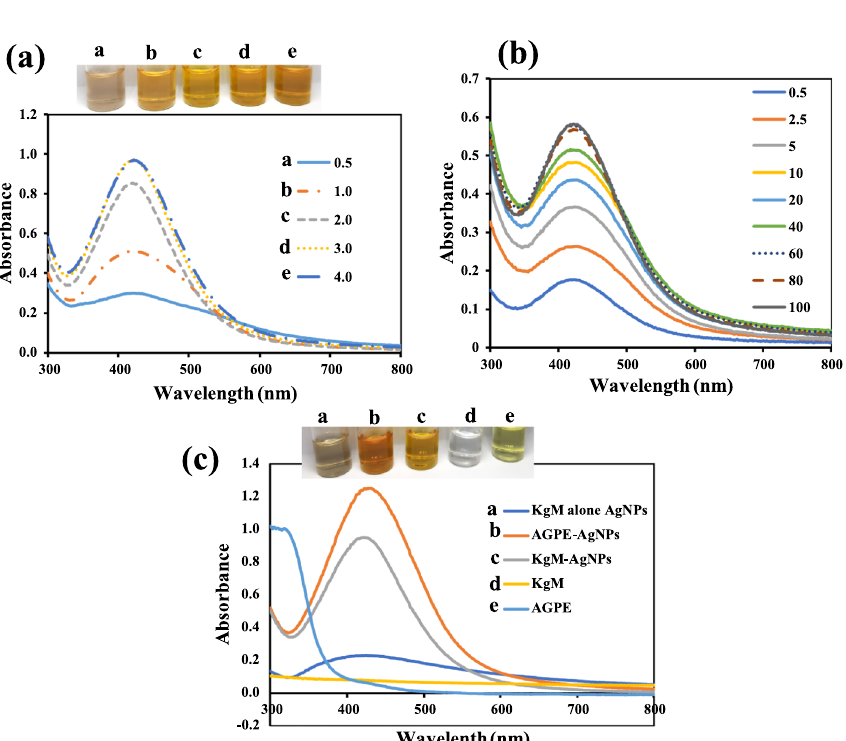
Figure 2. UV–vis absorption spectra of ( a ) Colloidal KgM-AgNPs realized using different concentrations of AgNO 3, a 0.5 b1.0 c 2.0 d 3.0 and e 4.0 mM, while inset shows the photo images, ( b ). UV–vis absorption spectra of 2.0 mM AgN0 3 , synthesis kinetics (0.5 to 100 min), selected as optimal condition and ( c ). UV–vis absorption spectra of materials and silver nanoparticles realized using varying materials, a. AgNPs using KgM alone b. AgNPs using AGPE alone ( c ). AGPE based synthesis of KgM-AgNPs d. KgM biopolymer and e. AGPE, while inset shows the photographic images of the different